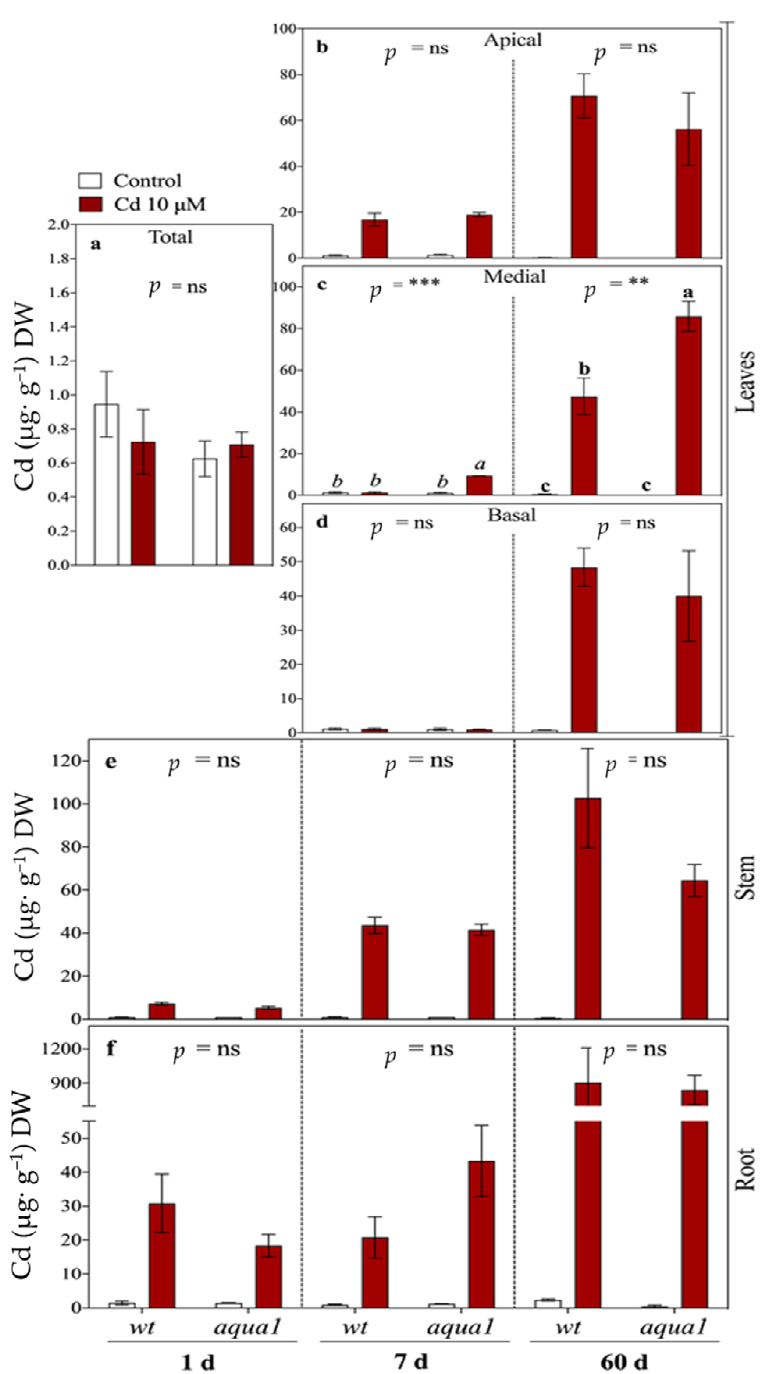
Figure 1. Cd concentrations ( µ g g − 1 DW) in leaves ( a – d ), stem ( e ), and root ( f ). In the first sampling time (1 d) total leaves were analyzed ( a ) while at 7 and 60 d leaves were divided in three groups: apical ( b ), medial ( c ), and basal ( d ). Values represent the mean of three biological replicates ± SE. Data were analyzed with two-way ANOVA; p -values correspond to the interaction between Cd and Line are reported in the figure (** = 0.001 < p < 0.01, *** = p < 0.001, ns = not significant). When the interaction was significant, different letters indicate significant differences among treatments at each sampling time and organ. Cd and Line p -values are reported in Supplementary Materials Table